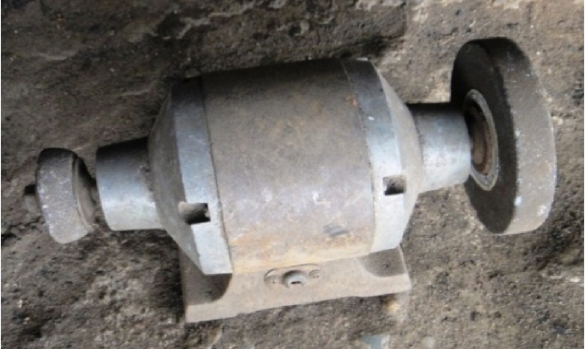
Figure 4 | Bench grinder (with a cutting discs). Photograph by Kingsley O. Emeriewen,